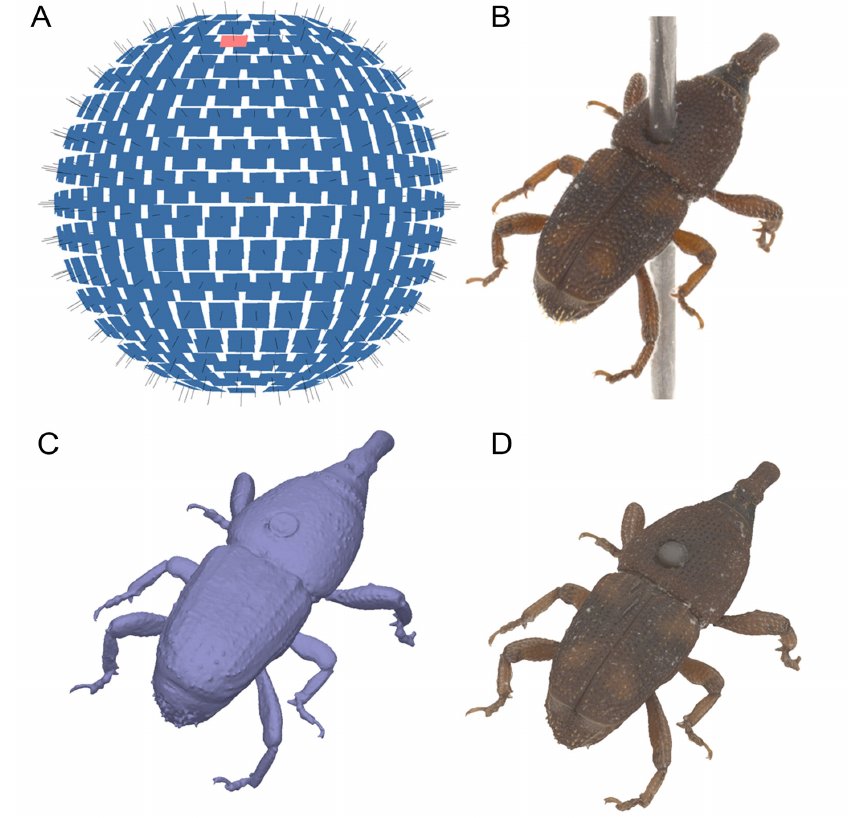
Fig. 3.12. Sitophilus oryzae (3.8mm body size) scanned with DISC3D. A . Scanning scheme with 398 camera positions. B . EDOF-image from the red camera position. C . Vcm-mesh (~250k polygones). D . Textured model.